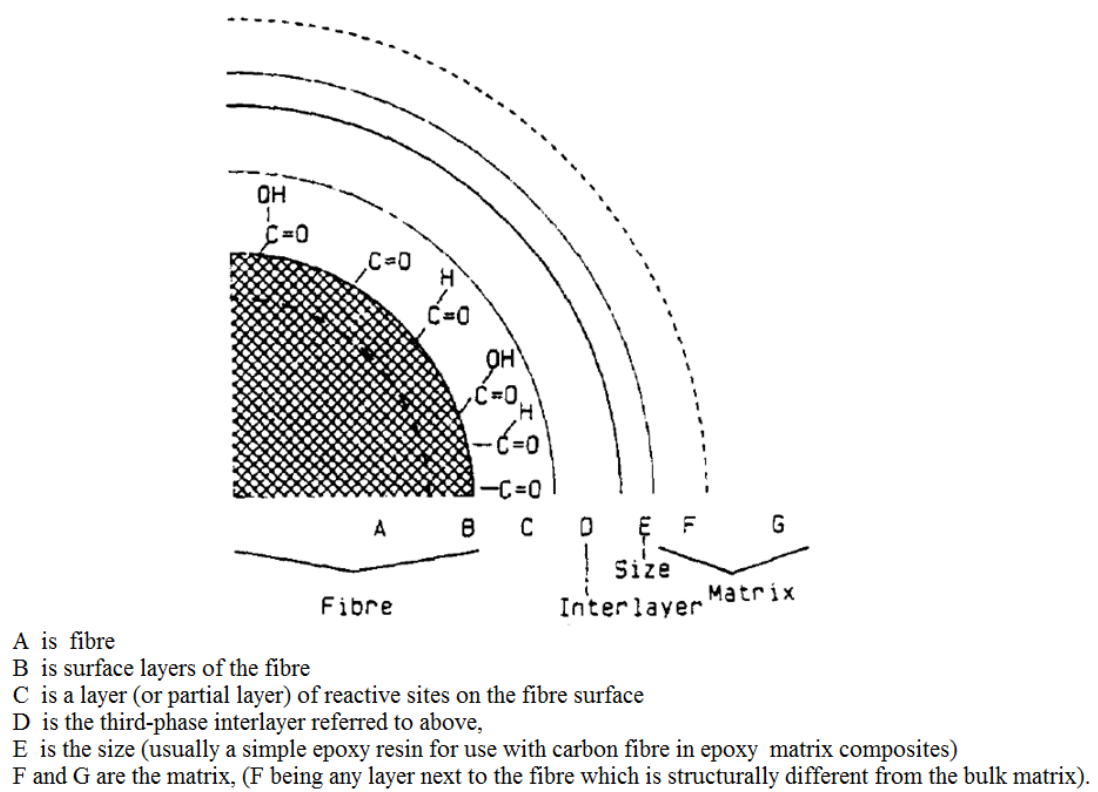
Figure 1. Regions of the carbon fiber-epoxy interface (Reproduced by permission from Elsevier from Ref. [171]).